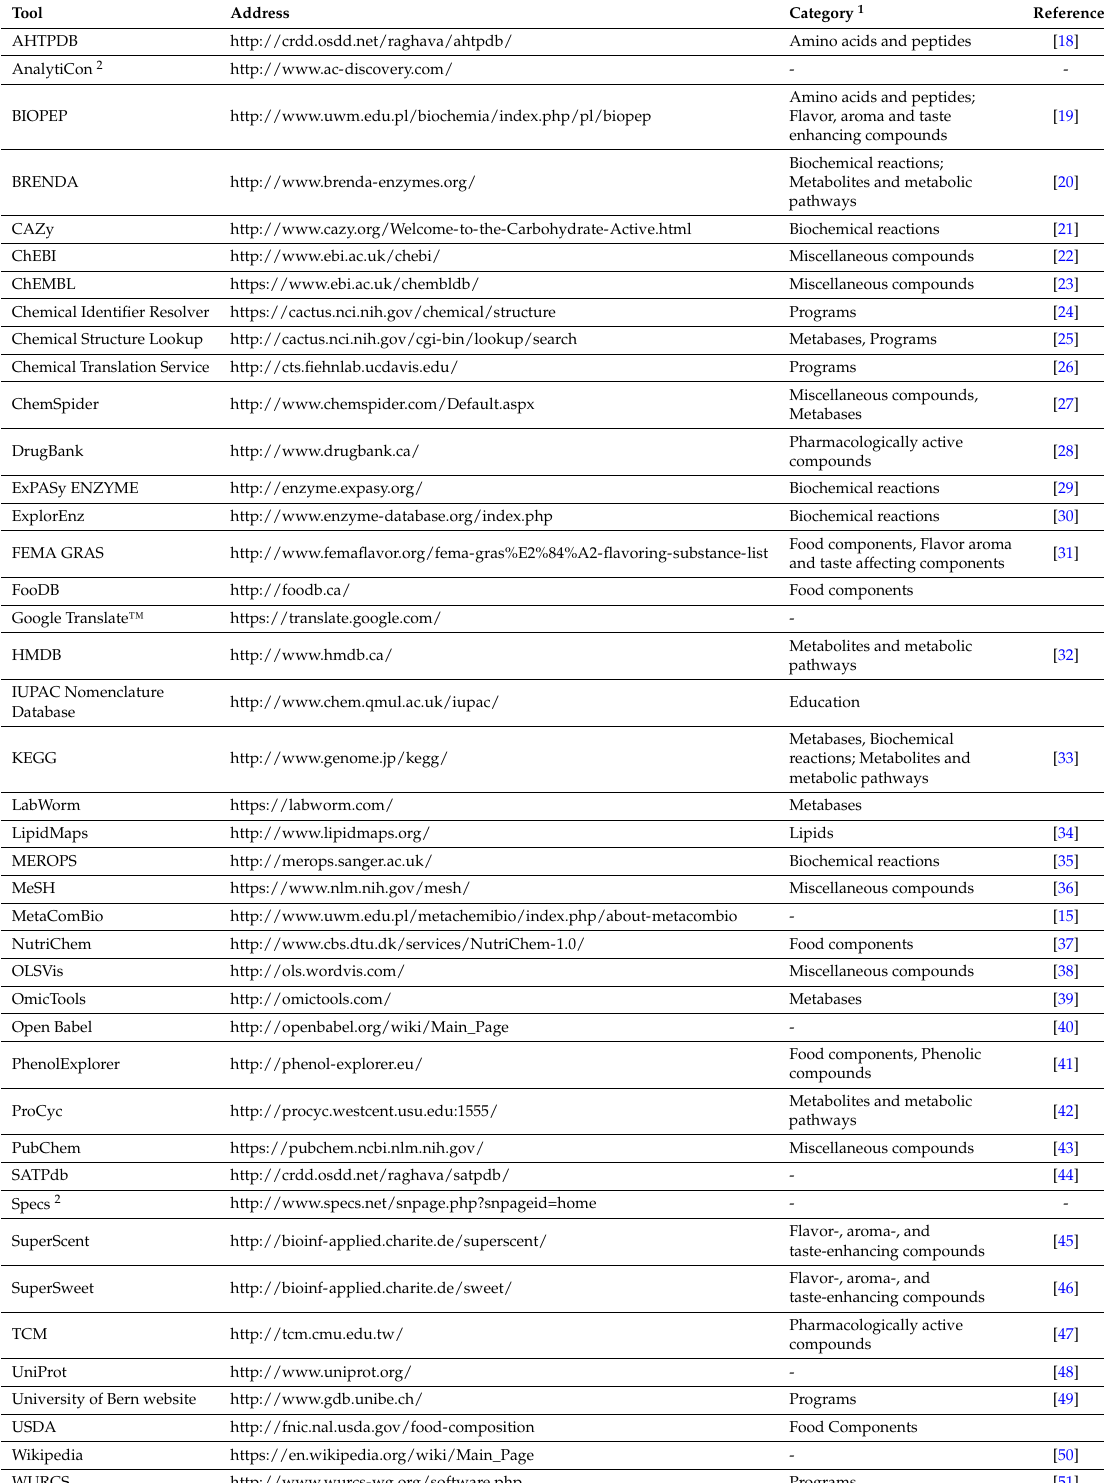
Table 1. Summary of databases and programs cited in this